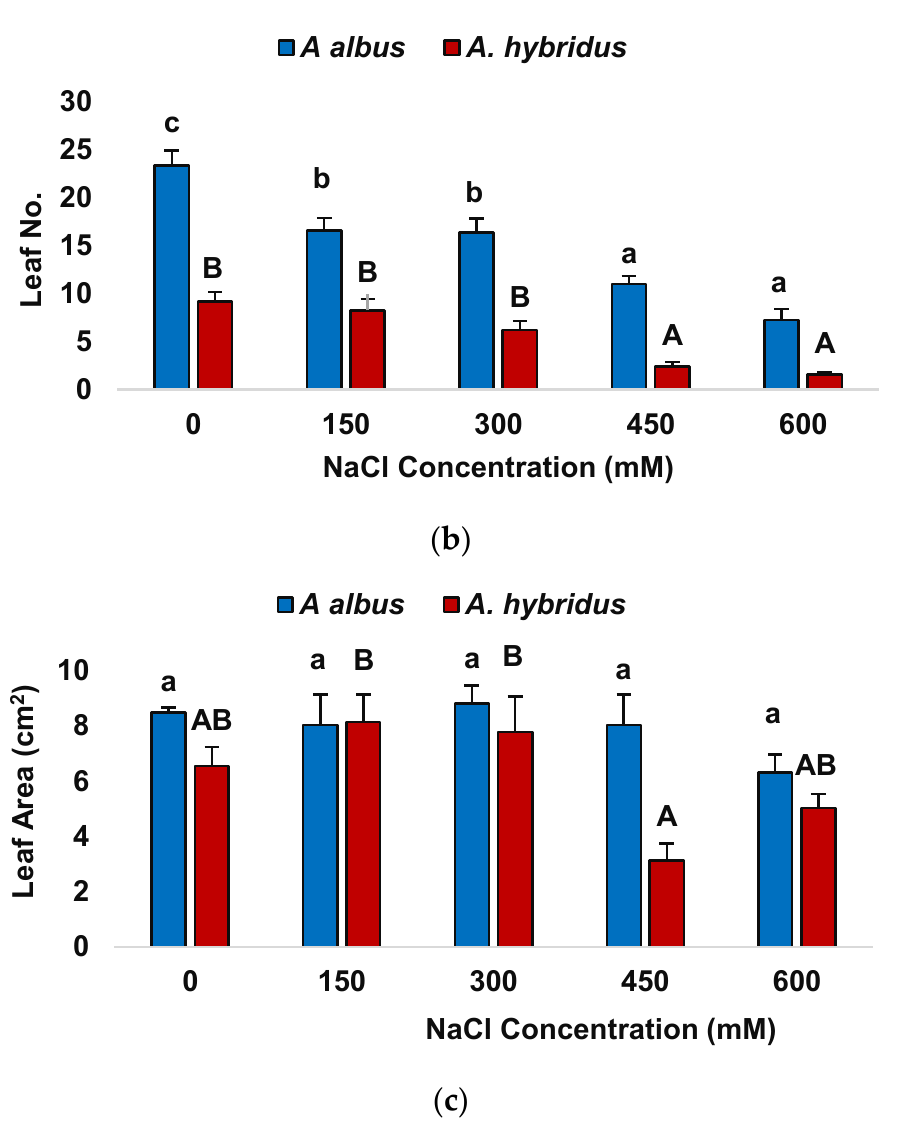
Figure 5. Growth parameters for the two Amaranthus species after one month of treatments with different NaCl concentrations: stem length ( a ) , number of leaves ( b ) and leaf area ( c ). Means ± SE, n = 7. Same letters indicate homogeneous groups between treatments for each species, according to the Tukey test ( α = 0.05). Lower-case letters were used for A. albus and capital letters for A. hybridus . The dry weight (DW) of roots and leaves excised from plants watered with the lowest concentration of NaCl were not significantly altered, and specifically for A. hybridus, even a small increase, although not statistically significant, was registered for plants watered with solutions of 150 mM and 300 mM NaCl. The dry weight of leaves was significantly reduced in plants watered with 450 mM NaCl solution, and under 600 mM NaCl treatment, a drop of more than 70% for A. albus and less than 60% for A. hybridus was registered (Figure 6a). The DW of roots was only significantly reduced in the two species in the plants from the 600 mM NaCl treatment in a similar proportion to that of leaves (Figure 6b). The water content of leaves (Figure 6c) showed only small fluctuations non related to the salt concentrations applied and the water content of roots did not show any variation (Figure